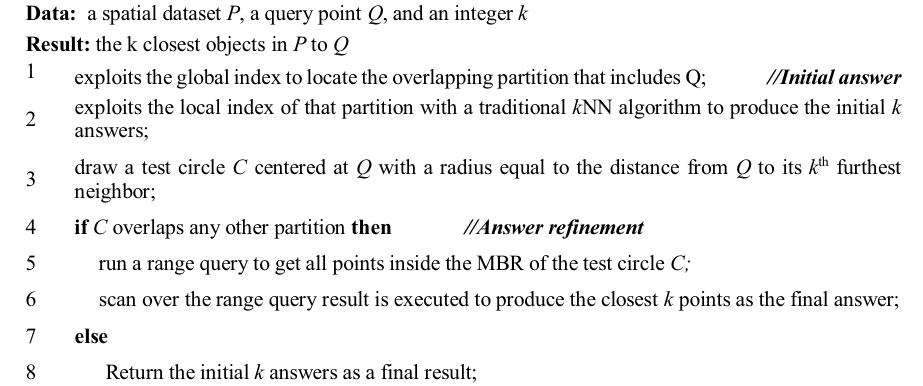
Algorithm 2: K NN execution working